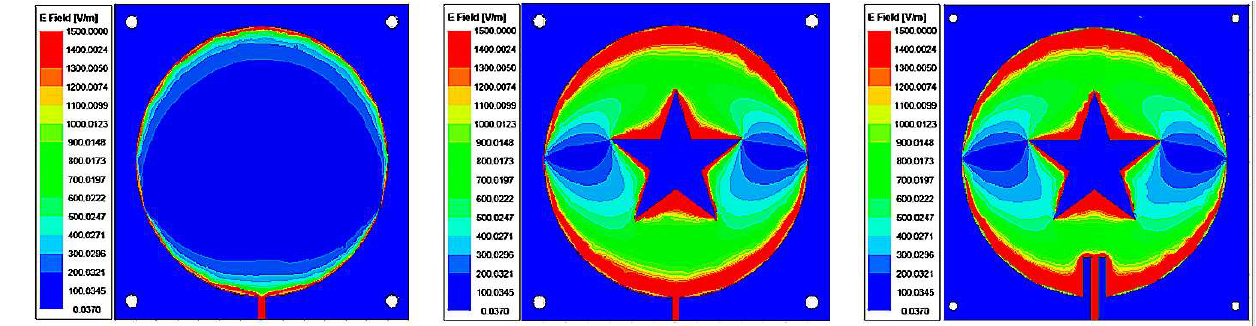
Figure 4. Electric field distribution at resonant frequency for different shaped